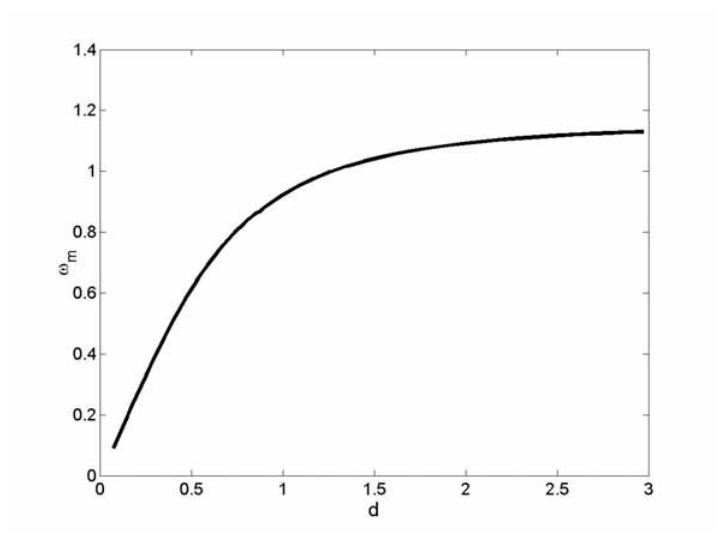
Fig. 24. Optimum curve in the ω m - d